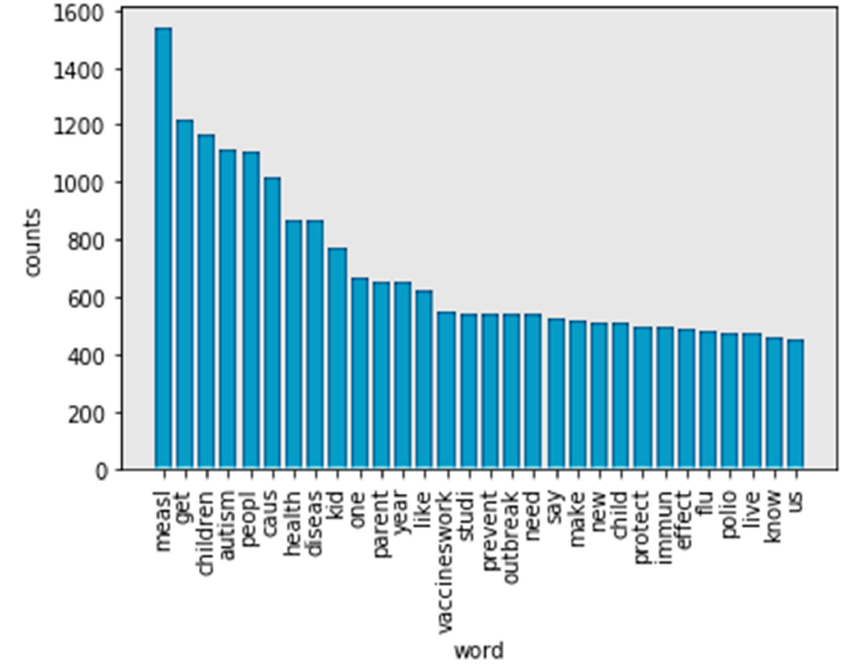
Figure 5. Top 30 frequency words in no-stop words tokens after processing by Porter stemmer.